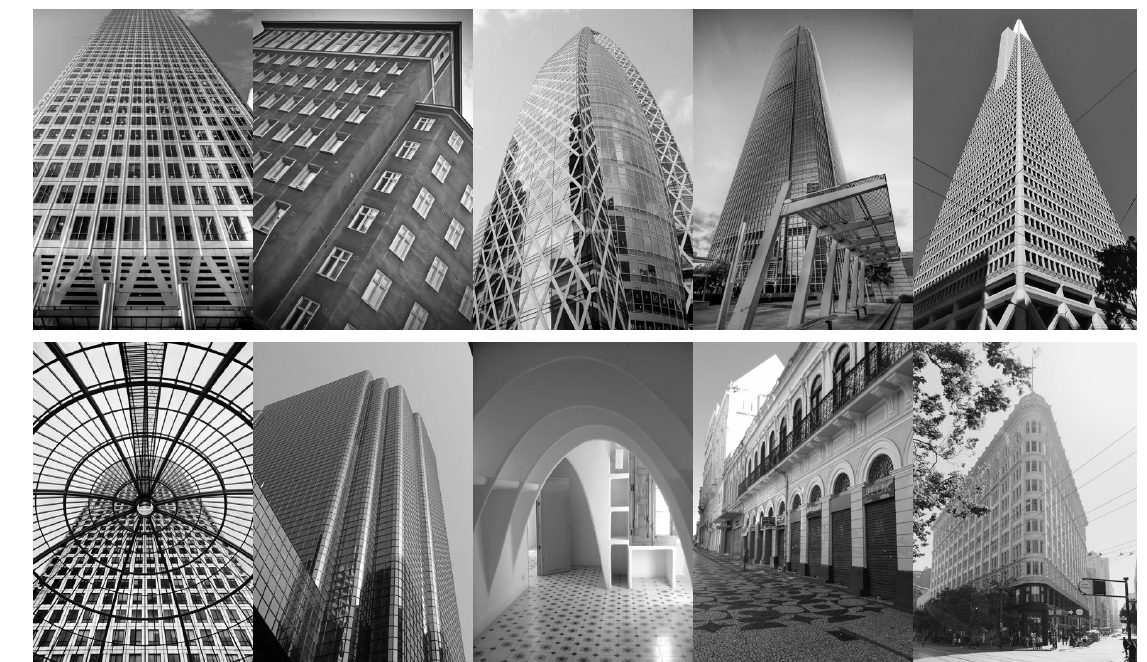
Figure 10. Some representative images in the Urban100 database. Table 2. PNSR(dB) results of two methods on 10 commonly used images with various noise